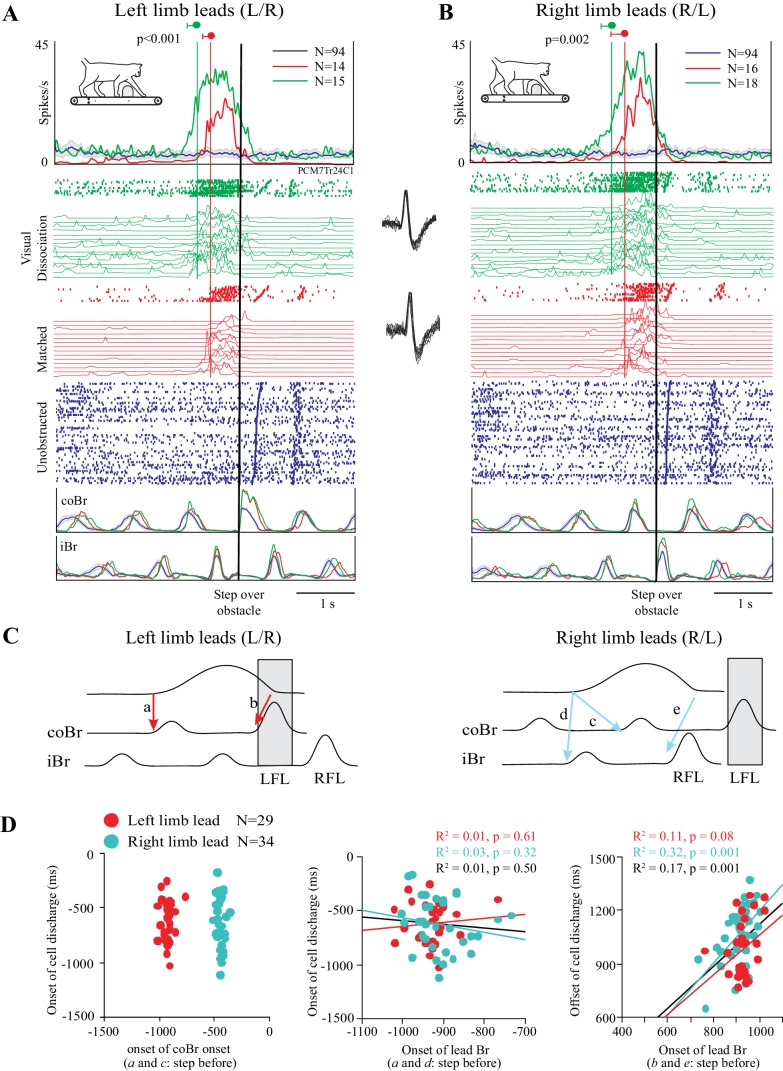
Discharge of an example cell during the matched and visual dissociation tasks.(A,B) Cell discharge during left and right limb lead condition. For each task, we illustrate the average discharge in the form of peri-event histograms (PEHs), together with the raster of cell activity, the instantaneous frequency during each trial, and the averaged activity of the coBr and iBr for the matched task (red), visual dissociation task (green), and for unobstructed walking (blue). Data are synchronized to the onset of activity (vertical black line) in the coBr (A) or the iBr (B) and displayed for 3200 ms prior to EMG onset and 2000 ms after. Vertical green and red lines and values indicate the average onset of cell activity during the visual dissociation and matched task, respectively, as calculated from the onset of the cell discharge in individual trials (see Figure 3—figure supplement 1). Insets between A and B show cell waveform during recordings of the matched (bottom trace) and visual dissociation (top trace) trials. (C) Schematic illustration showing selected temporal relationships tested between cell and muscle activity (see D). Shaded rectangle indicates the step over the obstacle by the left forelimb (LFL). RFL = right forelimb. (D) Linear regressions for cell onset vs. onset of the coBr during the step over the obstacle for the left and right limb lead condition (left); the relationship of cell onset to the onset of the flexor EMG in the lead limb in the step before the step over the obstacle (middle); and the end of cell discharge as a function of the onset of the activity in the Br of the lead limb during the step over the obstacle (right). Note that in the latter graph, measures are relative to the onset of activity in the Br in the preceding step. Data and linear regressions are shown for the left (red) and the right (cyan) limb lead conditions, together with the combined linear regression (black). (Figure 3—source data 1). Figure 3—figure supplement 1: Detection of bursts of unit activity in individual trials.10.7554/eLife.28143.009Figure 3—source data 1.Source data for graphs in Figure 3D.10.7554/eLife.28143.010Figure 3—source code 1.Script for data in Figure 3.